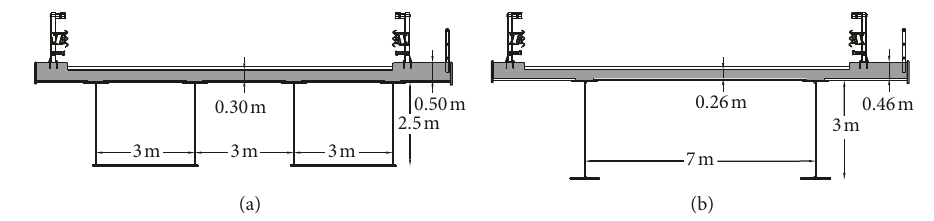
Figure 2: Cross sections of the two bridge design alternatives (D1 and D2).